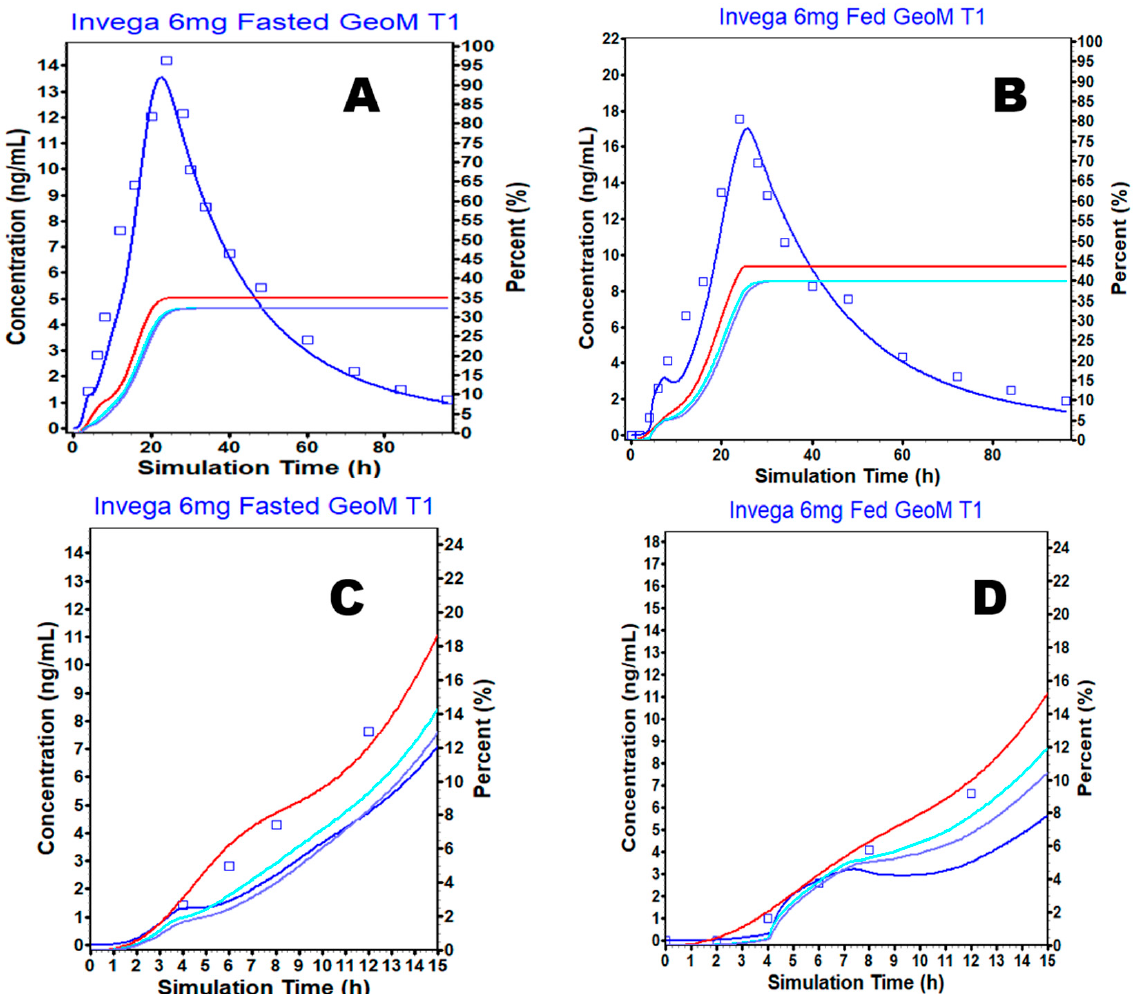
Figure 3. Predicted versus observed plasma concentrations over time after the oral administration of the PAL ER OROS tablet in ( A ) fasted and ( B ) fed (blue solid line—predicted plasma concentration, blue square box with bars—observed mean plasma concentration, red solid line—amount dissolved, purple solid line—amount to the portal vein, light blue solid line—amount absorbed). ( C , D ) are the same as ( A , B ) but with time truncated at 15 h to increase the resolution of the initial times.